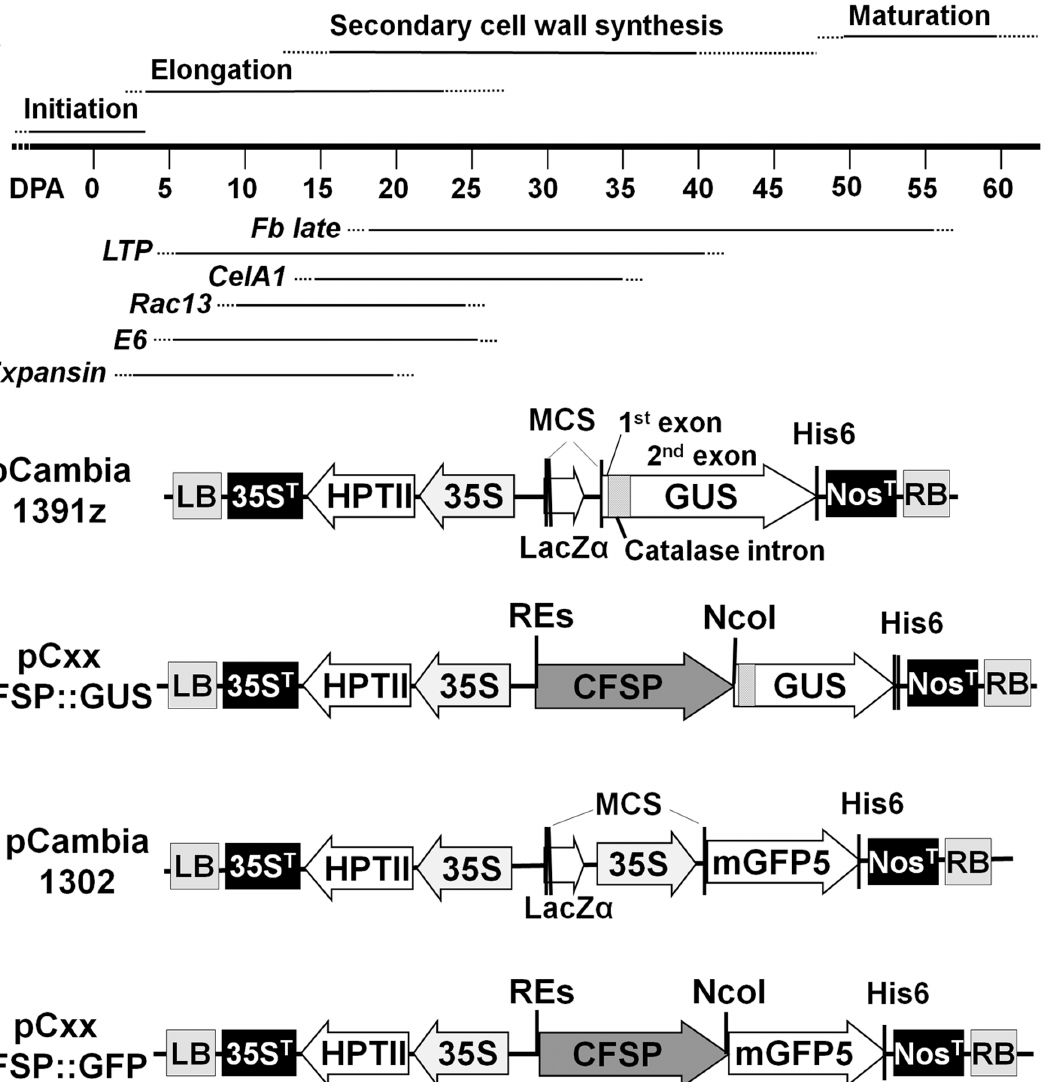
Fig 1. Schematic diagrams of (A) fiber developmental stages and activity of six cotton fiber specific genes during fiber development and (B-E) the pCambia binary vectors and cotton fiber specific promoter-reporter CFSP::GUS and CFSP::GFP constructs. (A) Schematic diagram showing the four developmental stages of cotton fiber and expression time frame of six corresponding cotton fiber specific genes during fiber development. All the cotton fiber specific promoter constructs contain a plant selectable marker gene cassette [cauliflower mosaic virus (CaMV) 35S::hygromycin phosphotransferase (HptII)- 35S terminator (35S t )] adjacent to the left border (LB) and a CFSP::reporter gene-6His tagged:nopaline synthase terminator [Nos T ] cassette adjacent to the right border (RB) of the binary vector, pC1391z and pC1302. (B) pCambia1391z T-DNA region showing the first exon, catalase intron, second exon and the His-6 tag of reporter GusA gene. (C) schematic diagram of CFSP::GUS constructs showing the CFSP linked to GusA reporter gene. (D) pCambia 1302 T-DNA region showing the CaMV 35S promoter::mGFP5-His6 structure. (E) schematic diagram of CFSP::mGFP5 showing the replacement of CaMV 35S with CFSP adjacent to mGFP5-His6 reporter